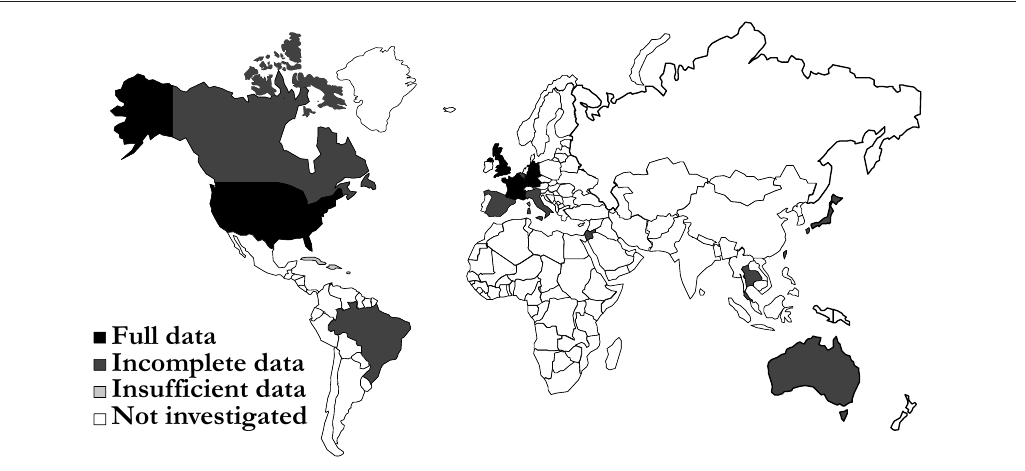
Figure 1. Data Availability for the Target